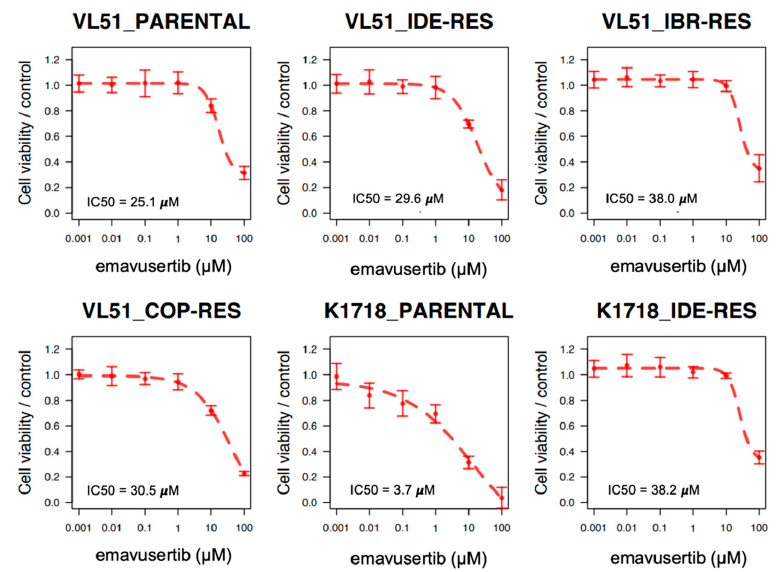
Figure 1. IRAK4 inhibitor emavusertib as single agent in MZL models. Dose–response curves (from three independent experiments), error bars and IC50 values of emavusertib in Karpas1718 (K1718) and VL51 parental cell lines or resistant models to idelalisib (IDE-RES) ibrutinib (IBR-RES) or copanlisib (COP-RES). Cells were exposed (72 h) to increasing doses of emavusertib as single agent followed by MTT assay. IC50 values were calculated using the four-parameter logistic regression.